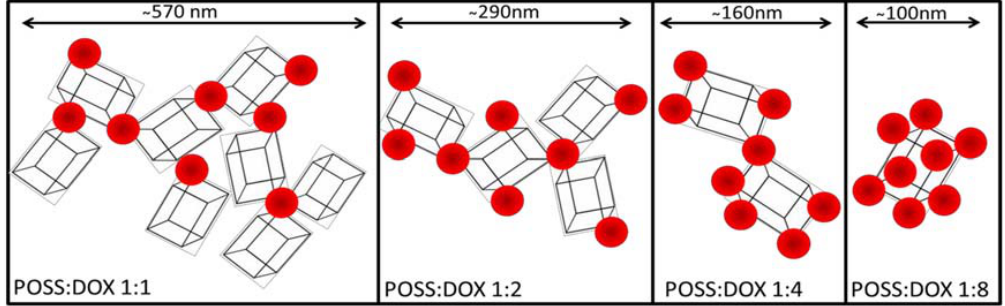
Figure 6. Proposed mechanism of complex formation by doxorubicin and polyhedral oligomeric silsesquioxane at different molar ratios.